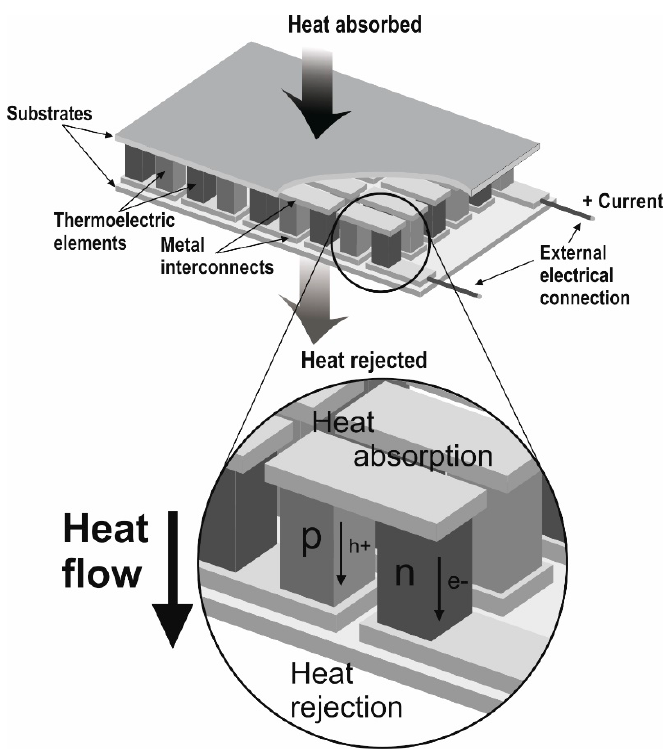
Figure 10 . Construction of a thermoelectric EH generator. Figure 10. Construction of a thermoelectric EH